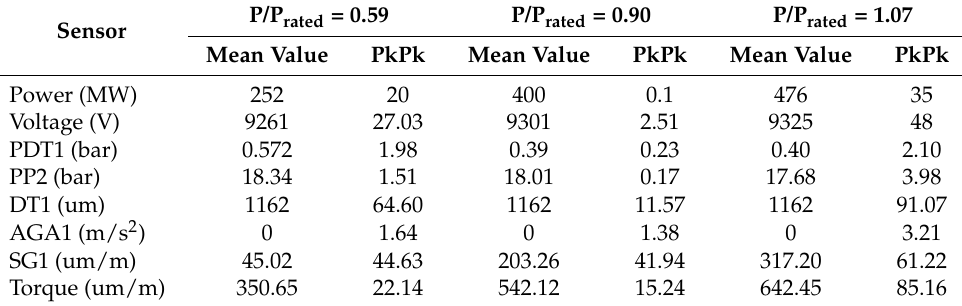
Figure 5. Time-signals for different sensors and different operating conditions. Every time division corresponds to 20 s of signal. Table 1. Mean Value and Peak to Peak (PkPk) values for different sensors and different operating conditions.